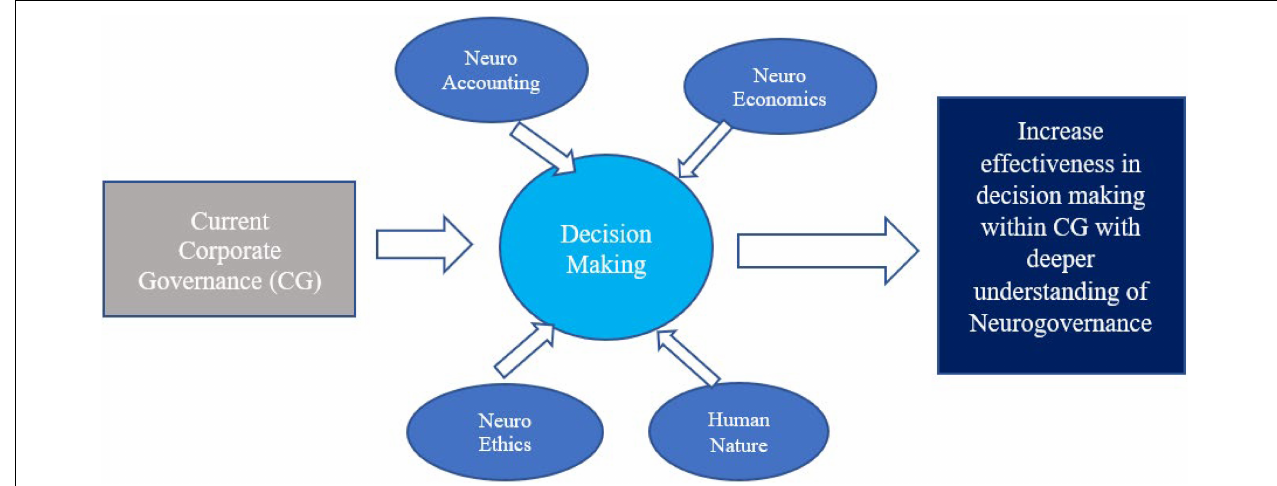
FIGURE 1 | Theoretical framework denotes the components that lead to neuro-governance (Source: Authors